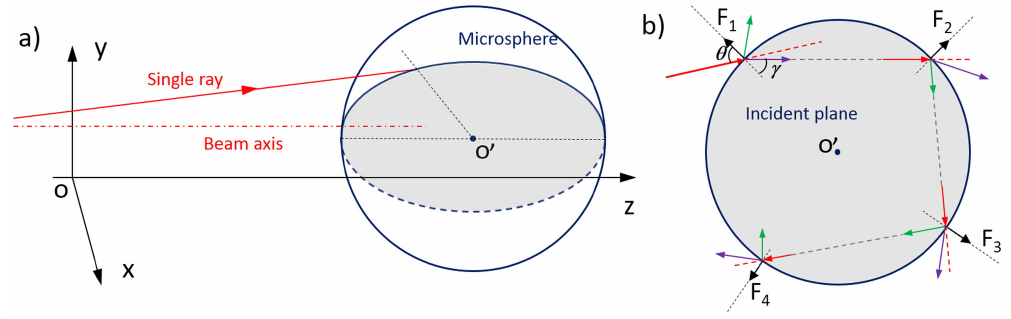
Figure 7. Coordinate system for a single ray interacting with a particle. ( a ) A single rays from a Gaussian laser beams hits on the surface of a particle. The locations of the laser beam and particle can be random. The incident plane is defined by the ray and the normal direction of the particle at the hitting point and is indicated by the gray area; ( b ) the single ray undergoes multiple reflections and refractions on the boundary of the